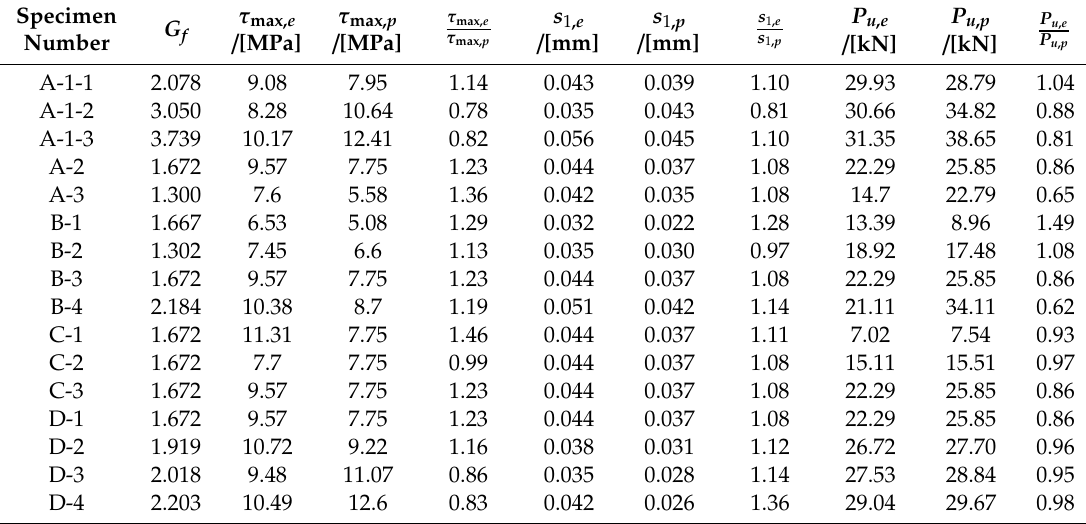
Table 4. Comparison of the theoretical predicted value calculated by the new interface constitutive model (Subscripted, “ p ”) and the experimental results (Subscripted, “ e ”). Specimen